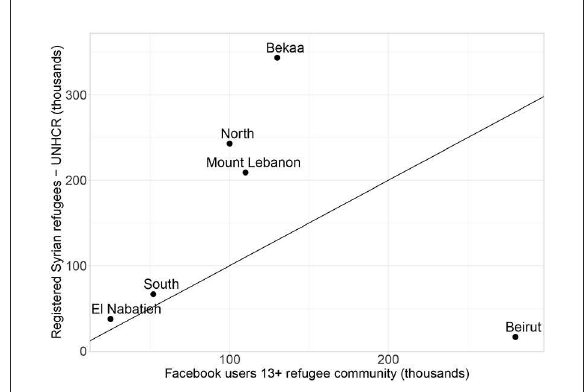
FIGURE3 Scatter plot of the number of Facebook users aged 13+ (refugee community) against the number of registered Syrian refugees based on UNHCR data at the governorate level. The plotted line is the diagonal line where the number of users equals the number of registered